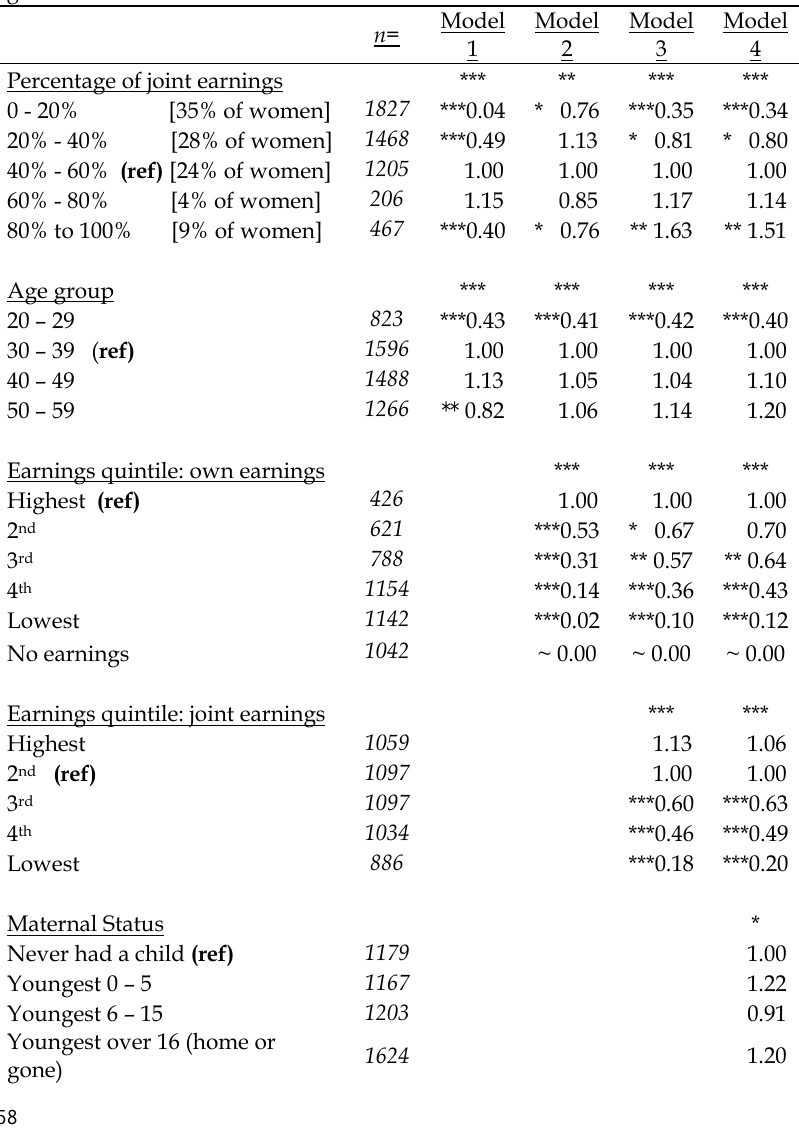
Table 2. Odds ratios for contributing to additional pensions: partnered women aged 20 to